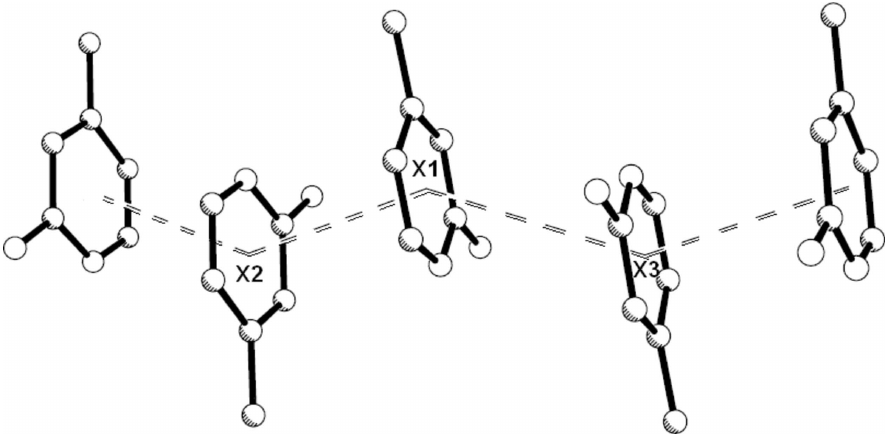
Figure 3 Cationic chains along the crystallographic c axis, assembled via offset face-to-face ( π – π stacking; double broken lines) motifs. Centroids separation distances are X2(2 - x , y , 3/2 - z )···X1 ( x , y , z )···X3(2 - x , - y , 2 - z ) are 3.61 (8) and 3.92 (2) Å,